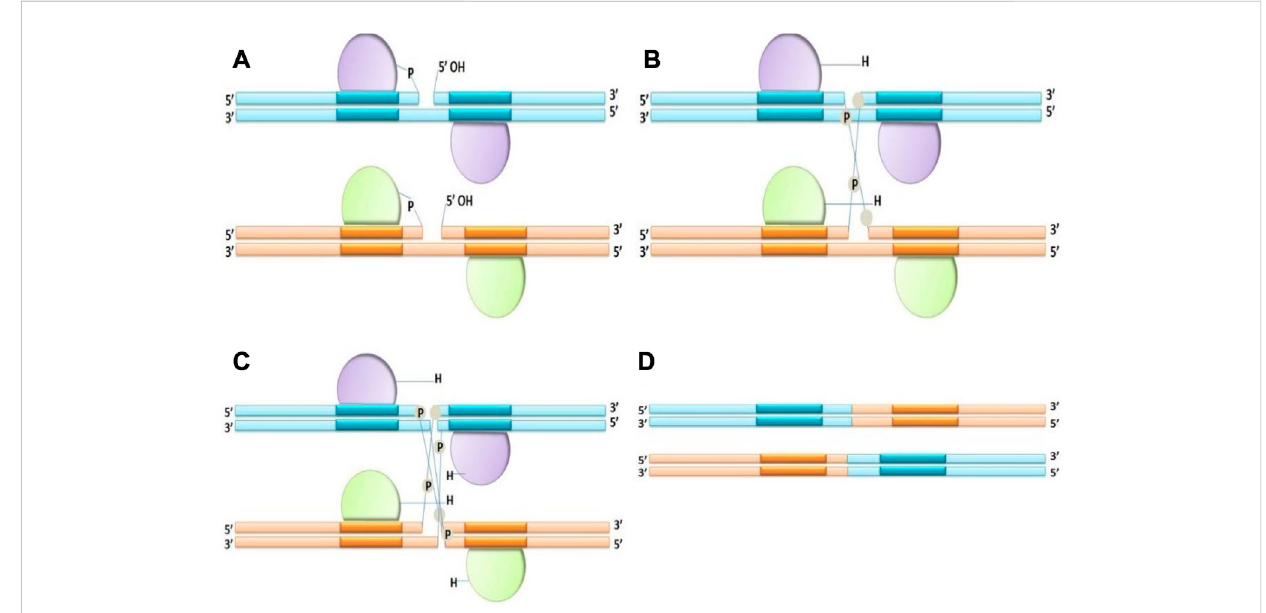
FIGURE 2 Mechanism of Tyrosine recombinase (A – D) , making an intermediate Holliday junction by expurgating and interchanging one pair of DNA strands, followed by cutting and interchanging the other couple of